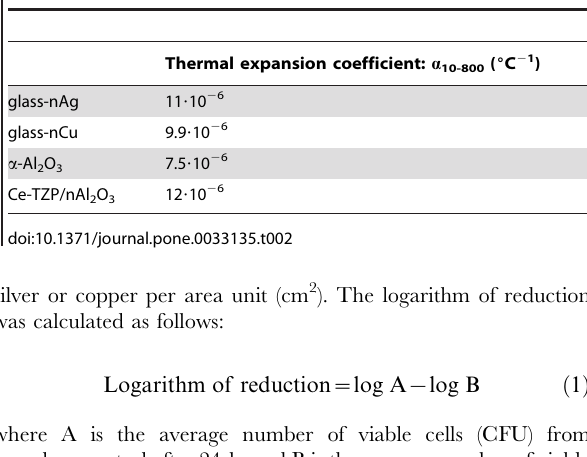
Table 2. Thermal expansion coefficients for the n-Ag glass, n- Cu glass, Ce-TZP/nAl 2 O 3 and